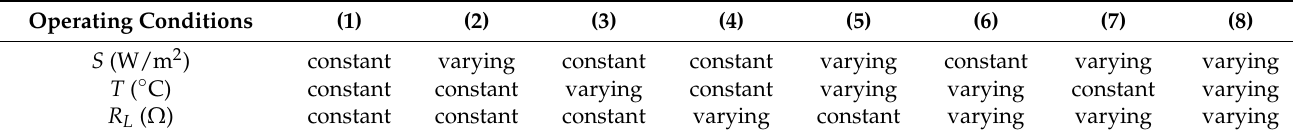
Table 6. Eight operating conditions of PV system.